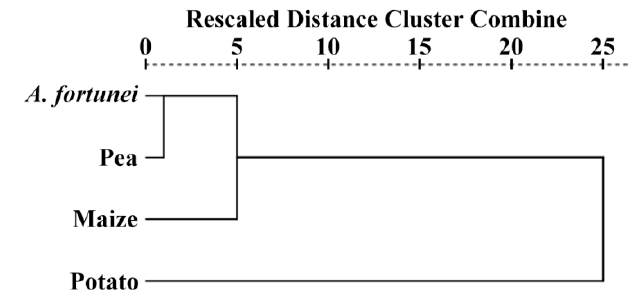
Figure 8. Dendrogram generated by hierarchical cluster analysis based on structural and functional property parameters of starches.